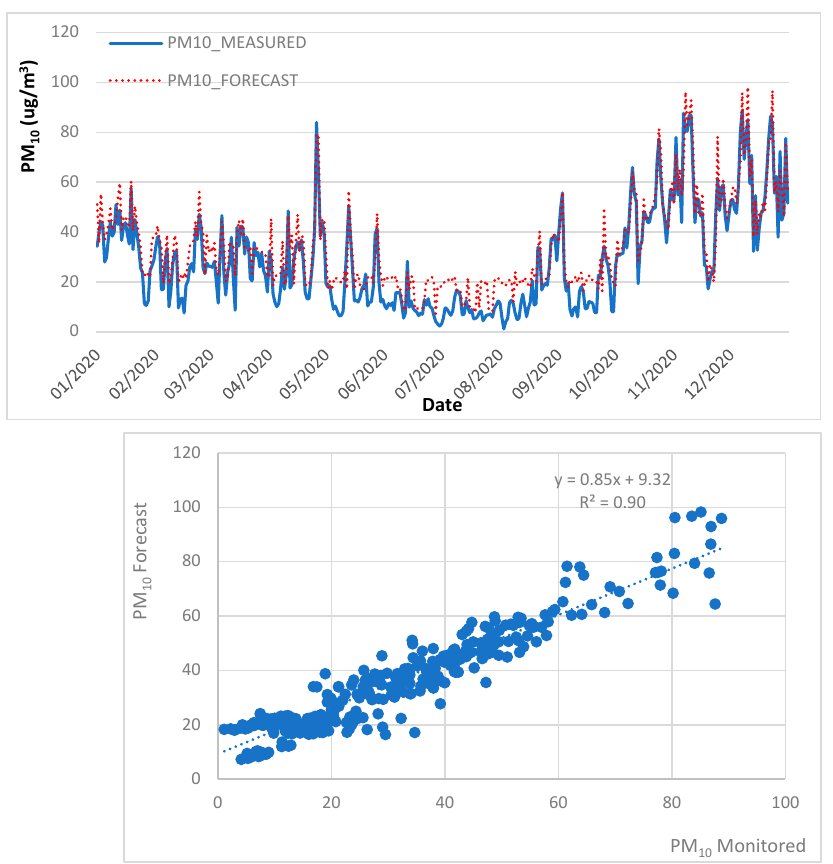
Figure 4. Observed and predicted PM 10 concentrations using RF for the year 2020.